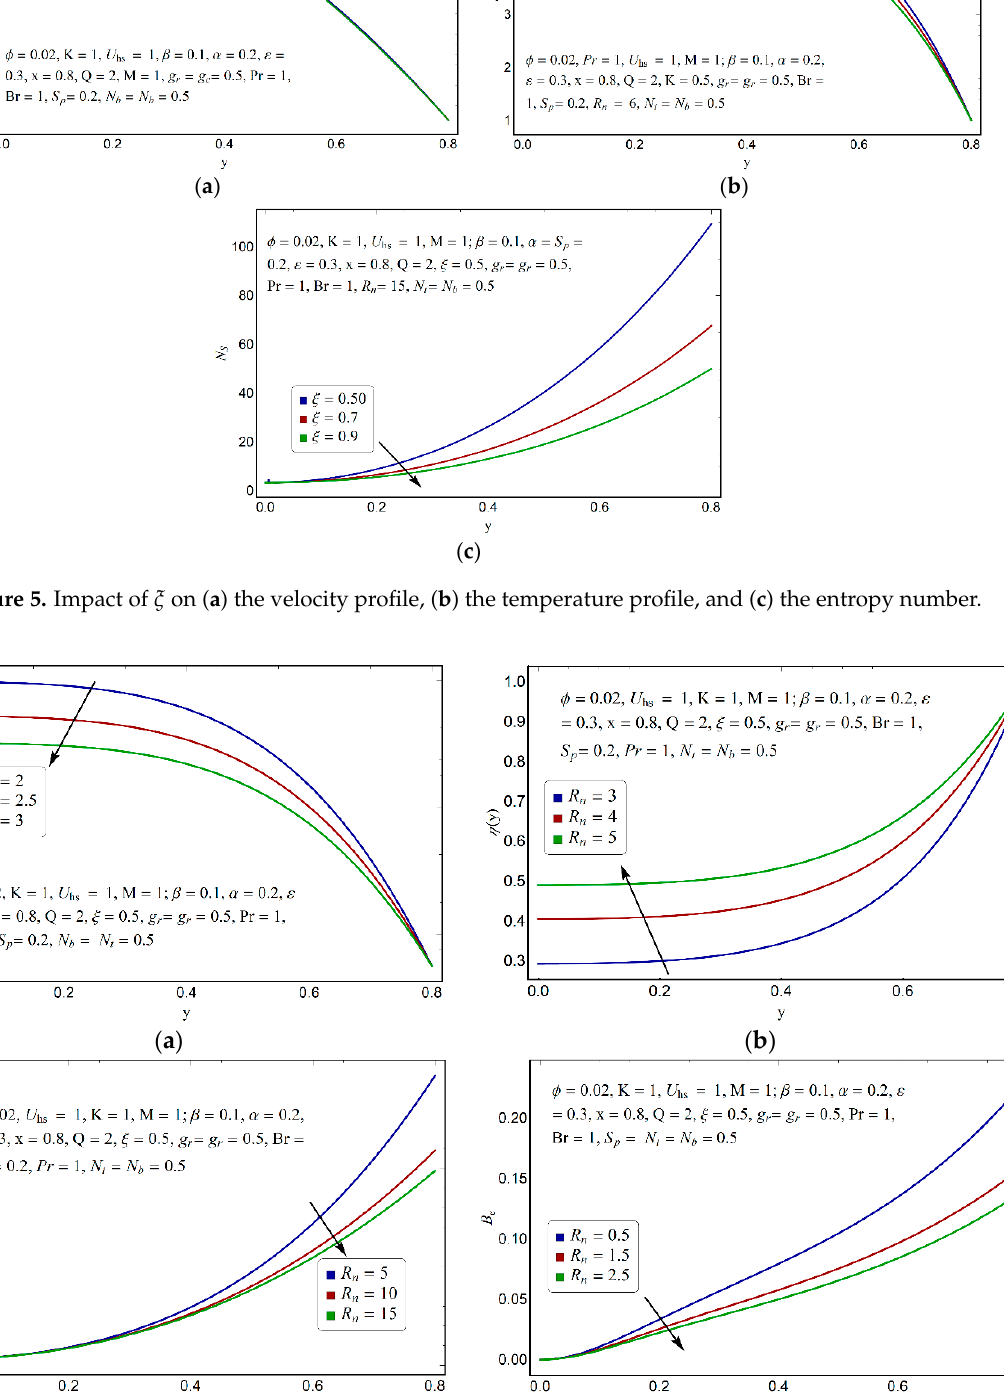
Figure 6. Impact of R n on ( a ) the temperature profile, ( b ) the mass concentration, ( c ) the entropy number, and ( d ) the Bejan number.